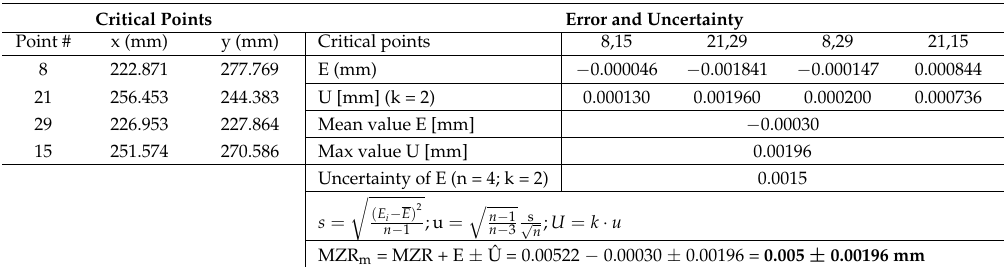
Table 5. Roundness measurement Case 5. Error and uncertainty results for minimum zone criteria. Values in (mm).